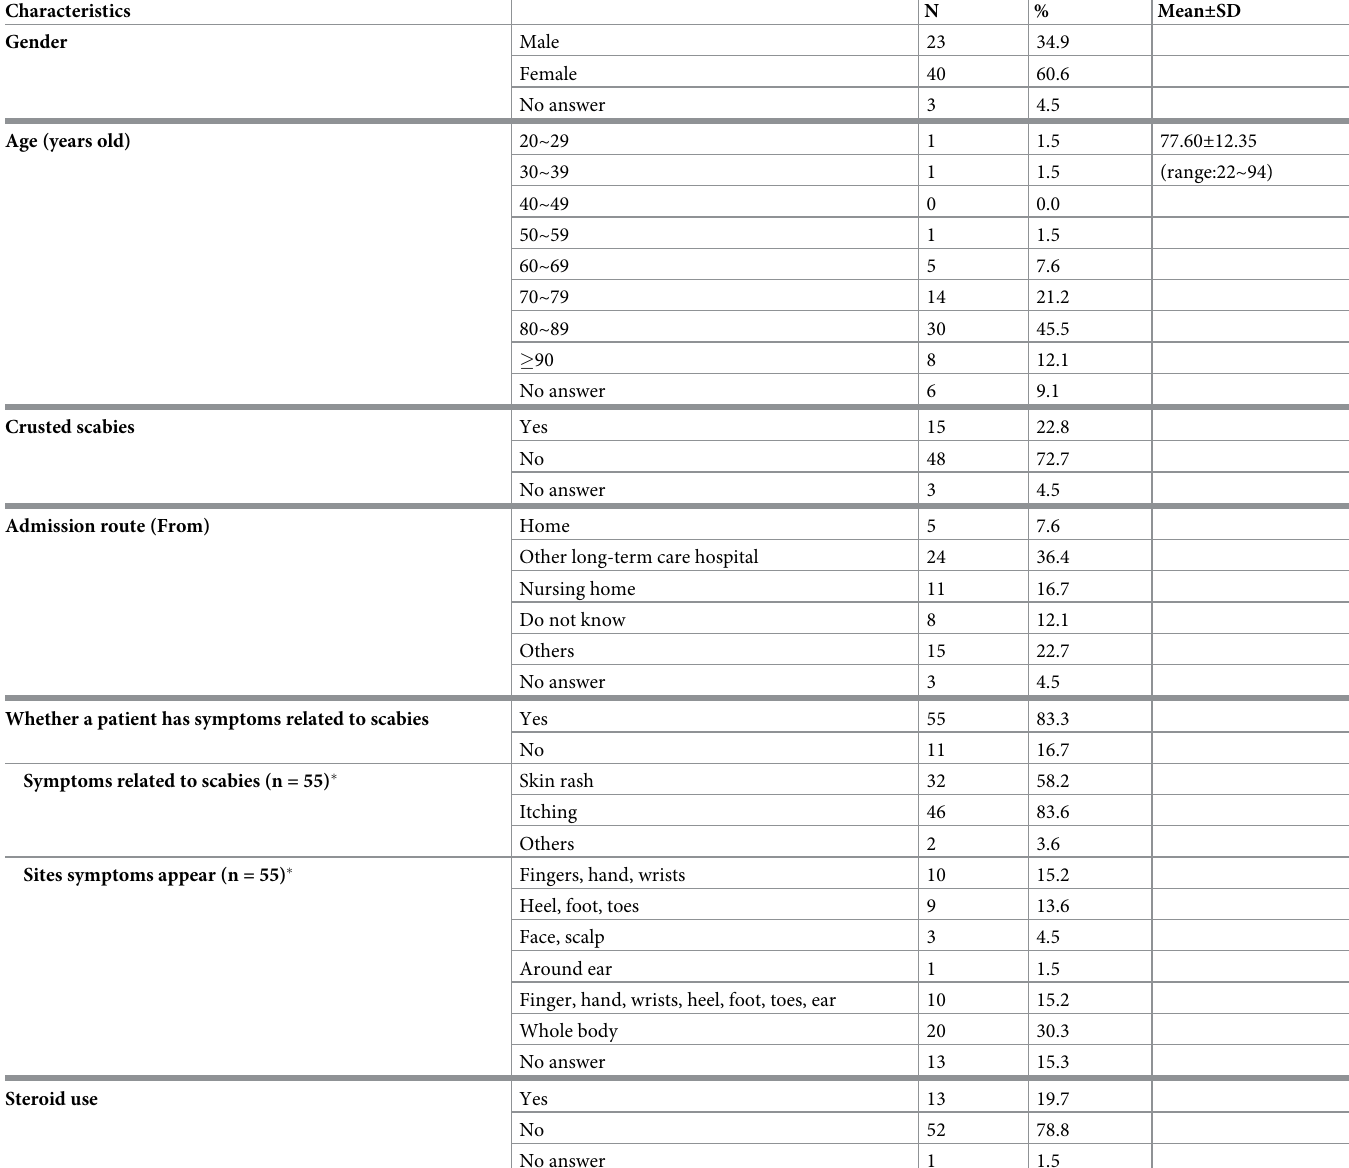
Table 4. General characteristics of the patients with primary infection (N = 66).